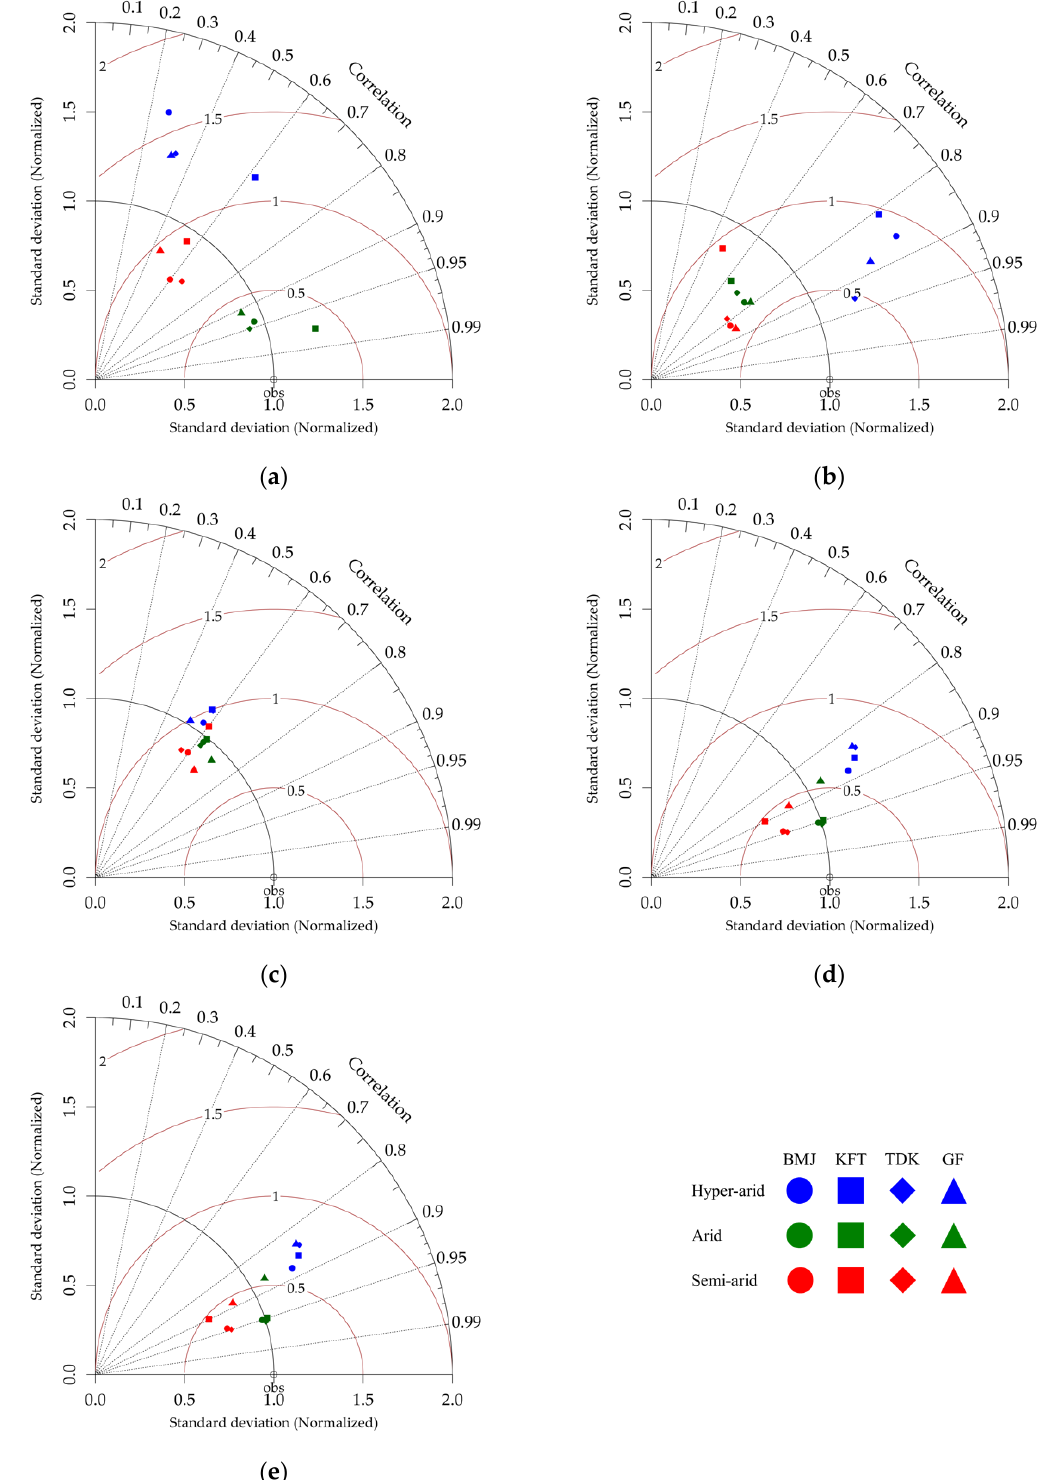
Figure 6. Normalized Taylor diagrams (obs: normalized standard deviation of observations) for monthly and seasonal minimum temperature during the dry season (November–February) in the hyper-arid, arid, and semi-arid zones of Sudan. BMJ, KFT, TDK, and GF are the Betts–Miller–Janjic, improved Kain–Fritch, modified Tiedtke, and Grell–Freitas schemes, respectively. ( a ) November. ( b ) December. ( c ) January. ( d ) February. ( e ) November–February.